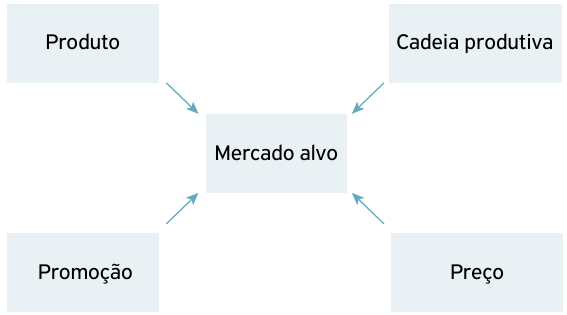
Figura 1. O composto de marketing